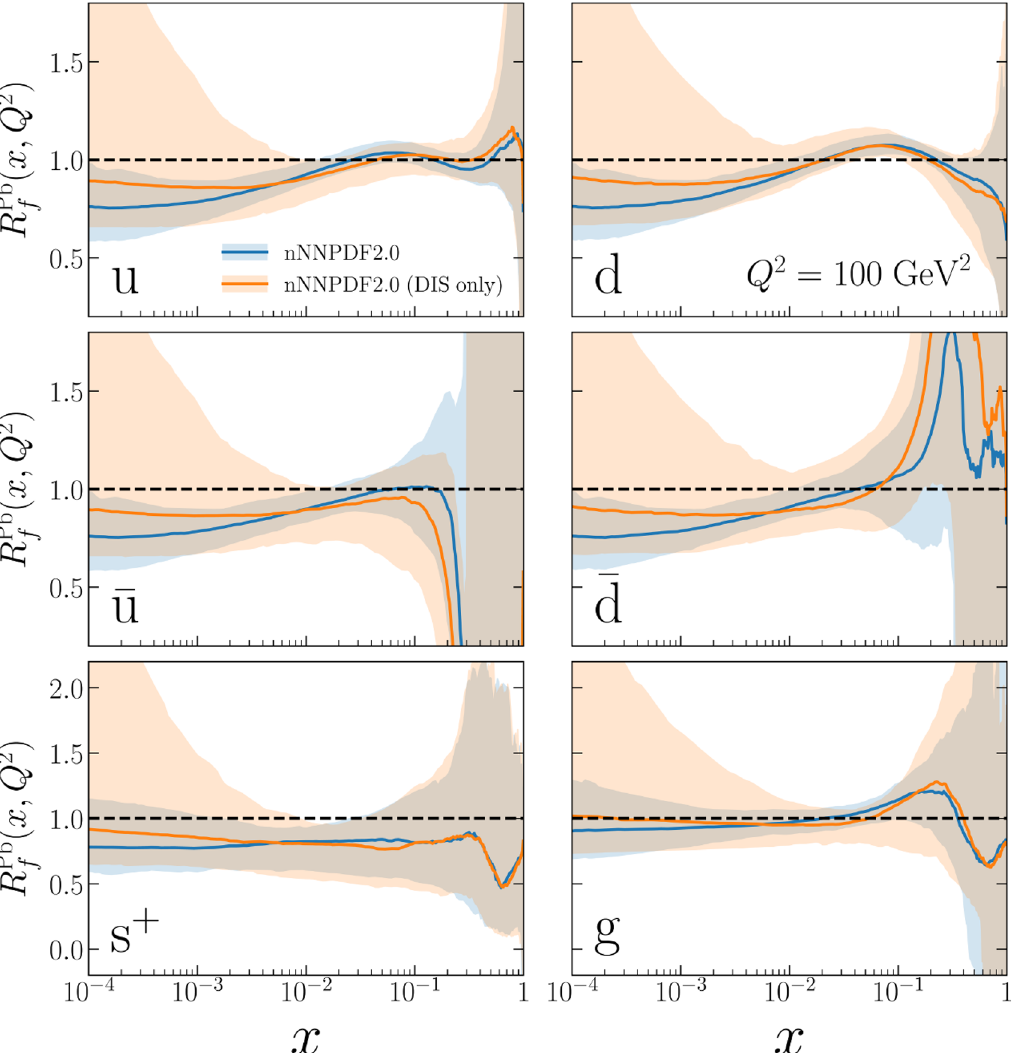
Figure 18 . Same as (cid:12)gure 14 now comparing the nNNPDF2.0 baseline results with those of a (cid:12)t based on identical settings but restricted to a DIS-only